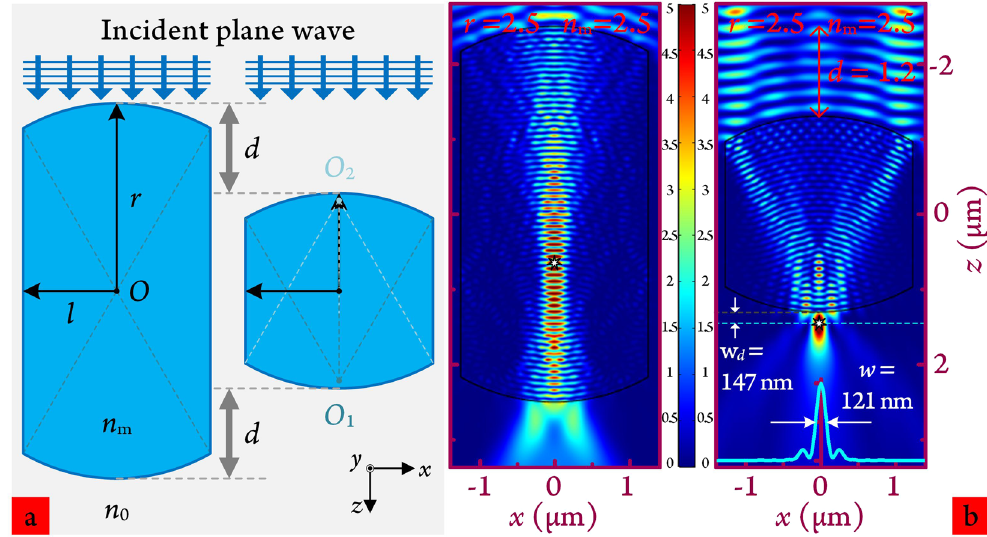
Figure 2. ( a ) Schematic illustration of MPCM transforming to R-MPCM by reducing the structure length in the vertical direction. The incident plane wave was propagated from top to bottom. ( b ) 2D electric field distributions of MPCM and R-MPCM (with reduced length 1.2 μ m) obtained from FEM-based full wave simulation. Inset: transverse intensity profile at the focal point. The two seven-pointed stars indicate maximum light intensity of the electric field intensity